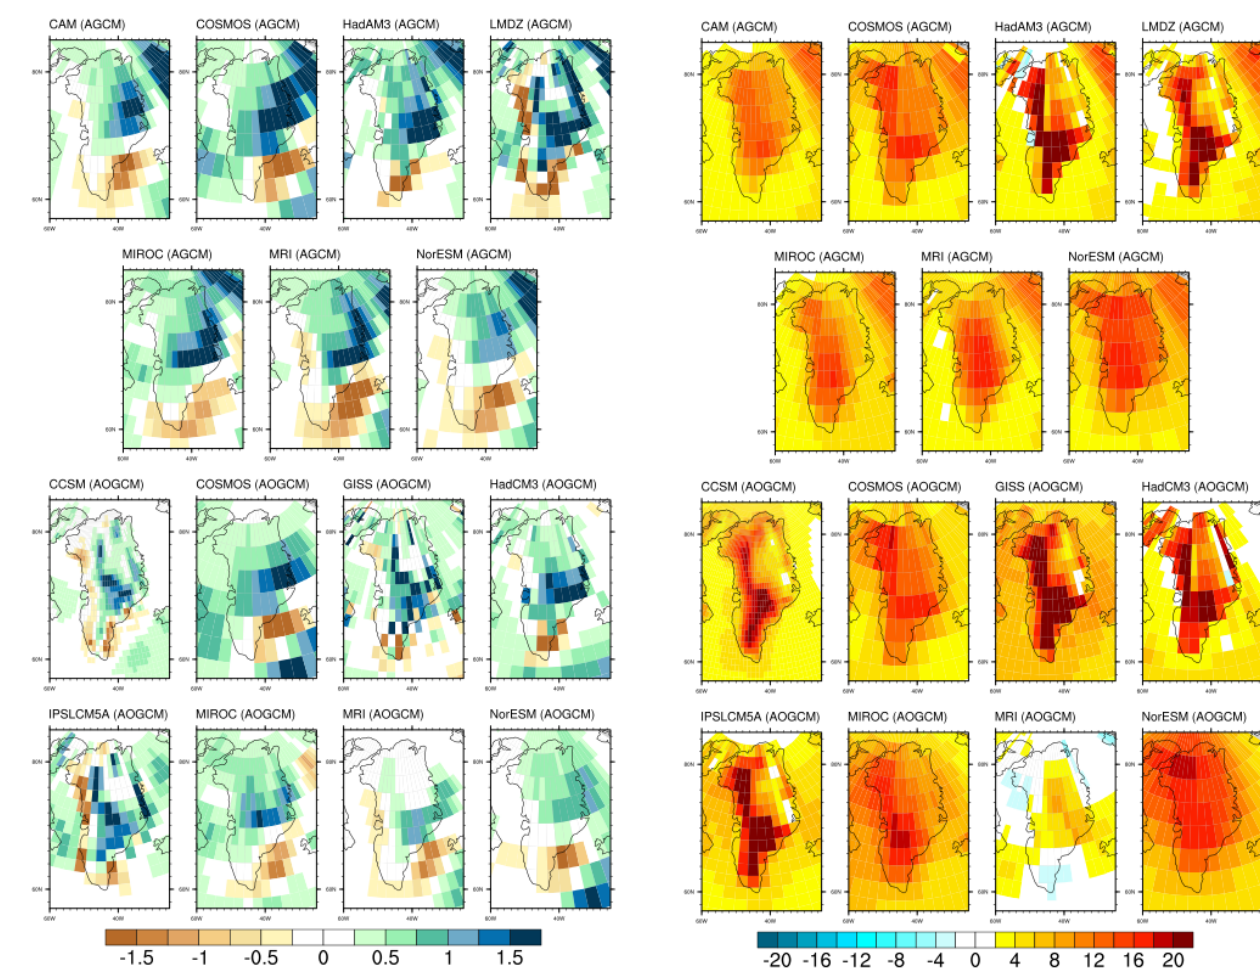
Figure 4. mPWP minus pre-industrial mean July surface air tem- perature ( ◦ C) over Greenland for the PlioMIP ensemble using atmosphere-only (AGCMs) and coupled atmosphere–ocean climate models (AOGCMs). Temperature plotted on the original climate model